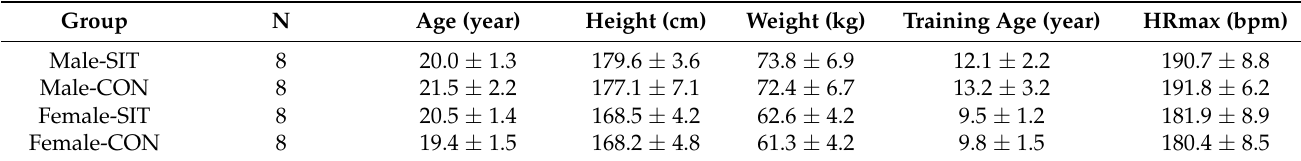
Table 1. Personal information of participating players.